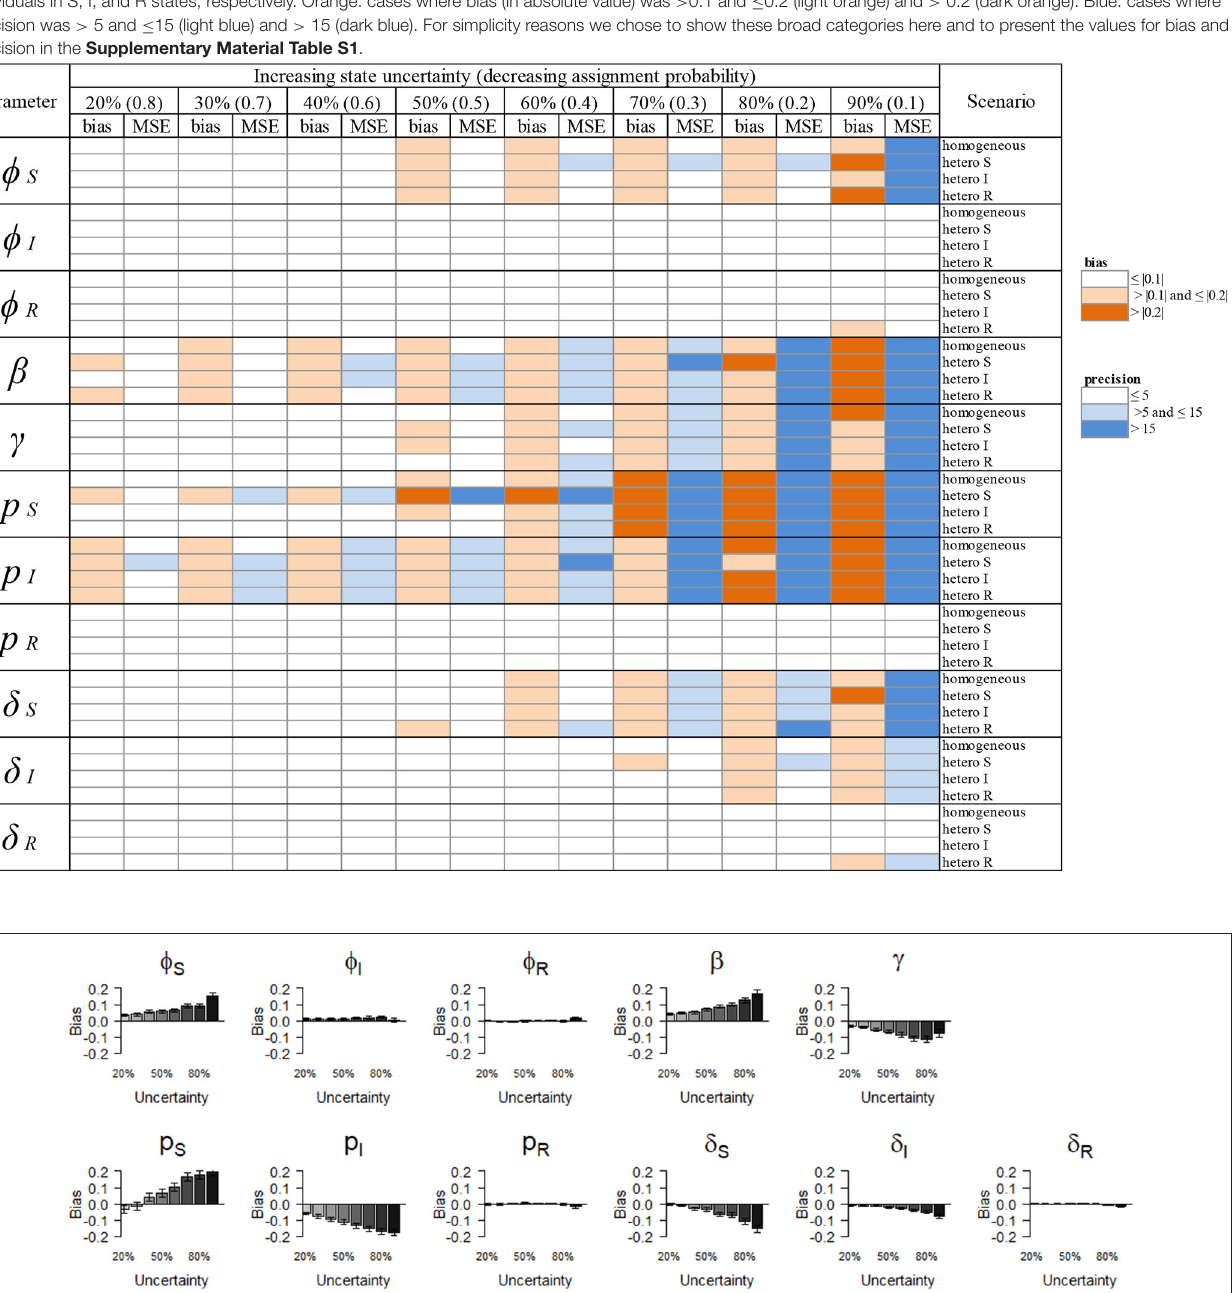
FIGURE 3 | Bias (mean difference between the parameter value estimated via simulations and the input parameter value) of parameter estimates as a function of homogeneously increasing infection state uncertainty. Error bars represent 95% CI. The increasing state uncertainty on the x-axis corresponds to a decreasing probability of assigning an infection state. We used the following notations for the parameters: φ S , φ I , and φ R for the survival probability of individuals in S, I, and R states, β for the infection probability, p S , p I and p R for the detection probability and δ S , δ I and δ R for the assignment probability of individuals in S, I, and R states,